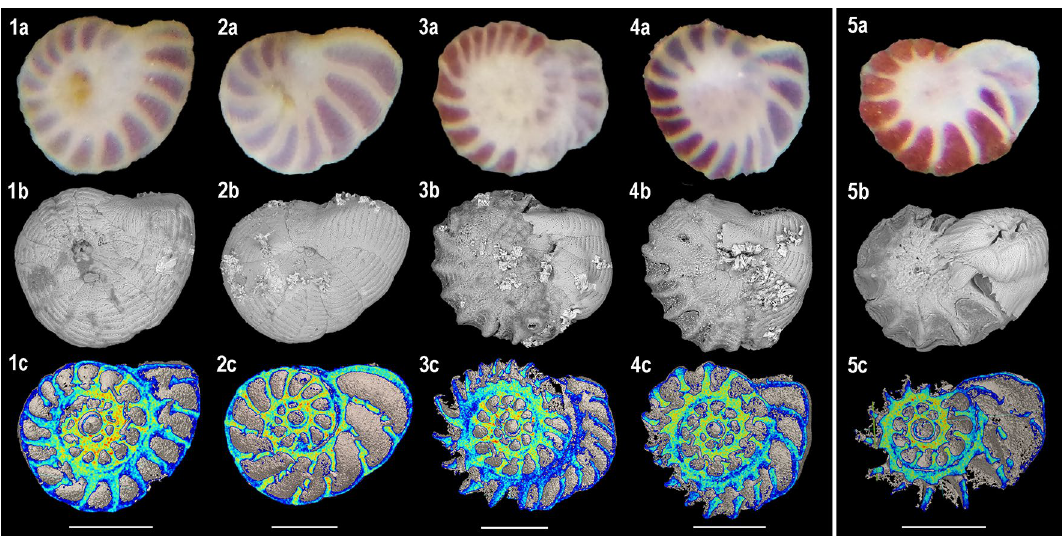
Figure 4. Light micrographs (above), SEM micrographs (middle) and cross-sections (below) of Peneroplis spp. specimens after the recovery phases. ( 1 ) 3 days at pH 7.9 + 32 days at pH 7.9, 1 new chamber; ( 2 ) 3 days at pH 7.4 + 32 days at pH 7.9, no new chamber; ( 3 ) 3 days at pH 6.9 + 32 days at pH 7.9 + food, 8 new chambers; ( 4 ) 3 days at pH 6.9 + 32 days at pH 7.9, 4 new chambers; ( 5 ) 32 days at pH 7.4 + 15 days at pH 7.9, 2 new chambers. Colors are relative densities. Scale bars are 200